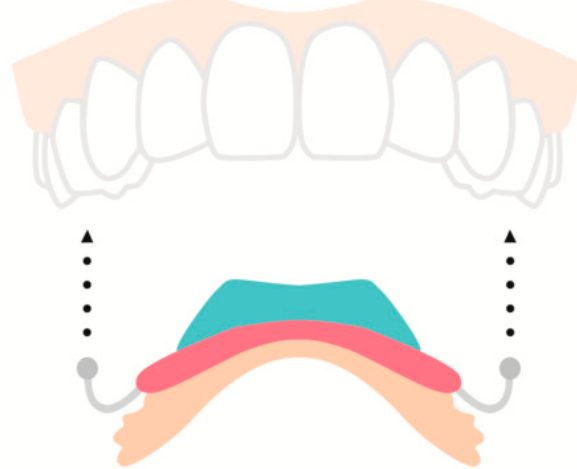
Figure 2. This oral device is placed in the upper palatal space and is secured by metal clasps right before initiation of eating. A microchip (shown in blue) records the device’s temperature in order to monitor the user’s compliance. It is designed to decelerate eating rate by decreasing oral volume and the size of each bite [47].